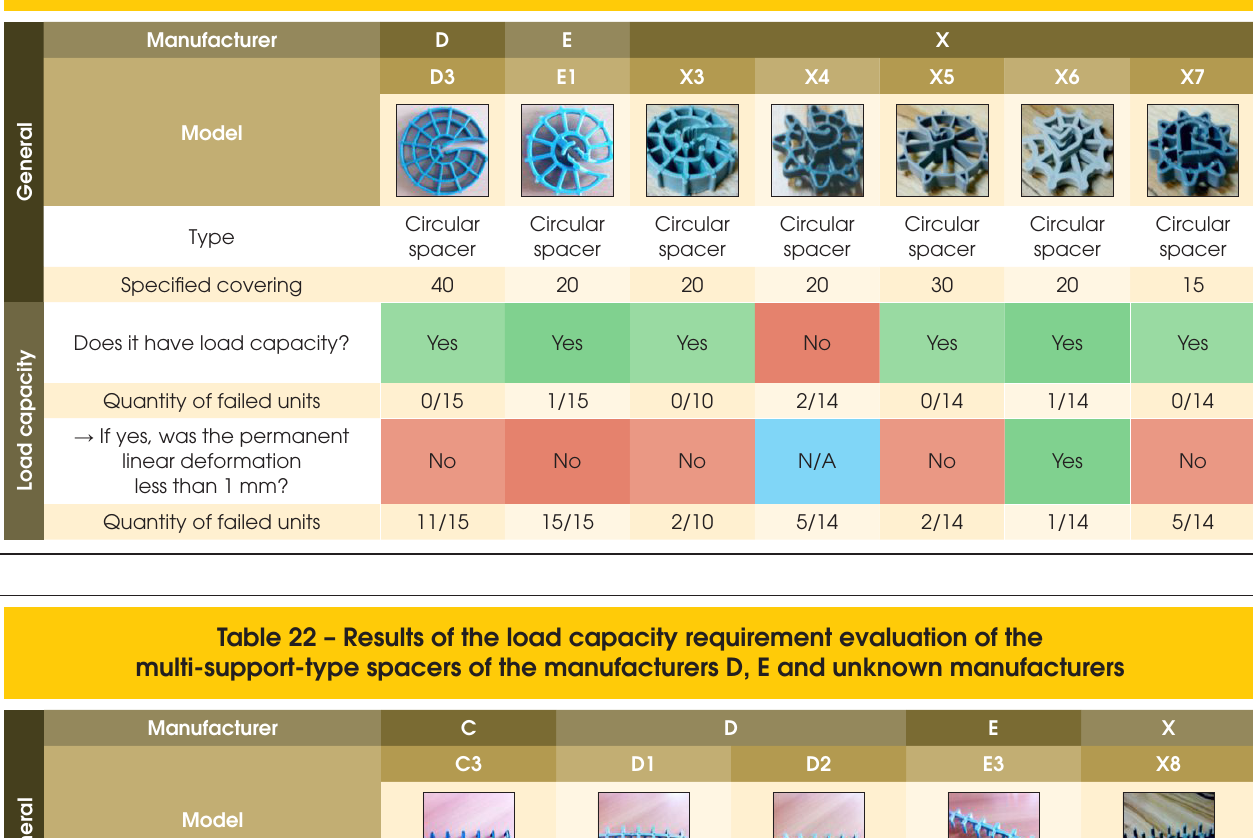
Table 21 – Results of the load capacity requirement evaluation of the circular-type